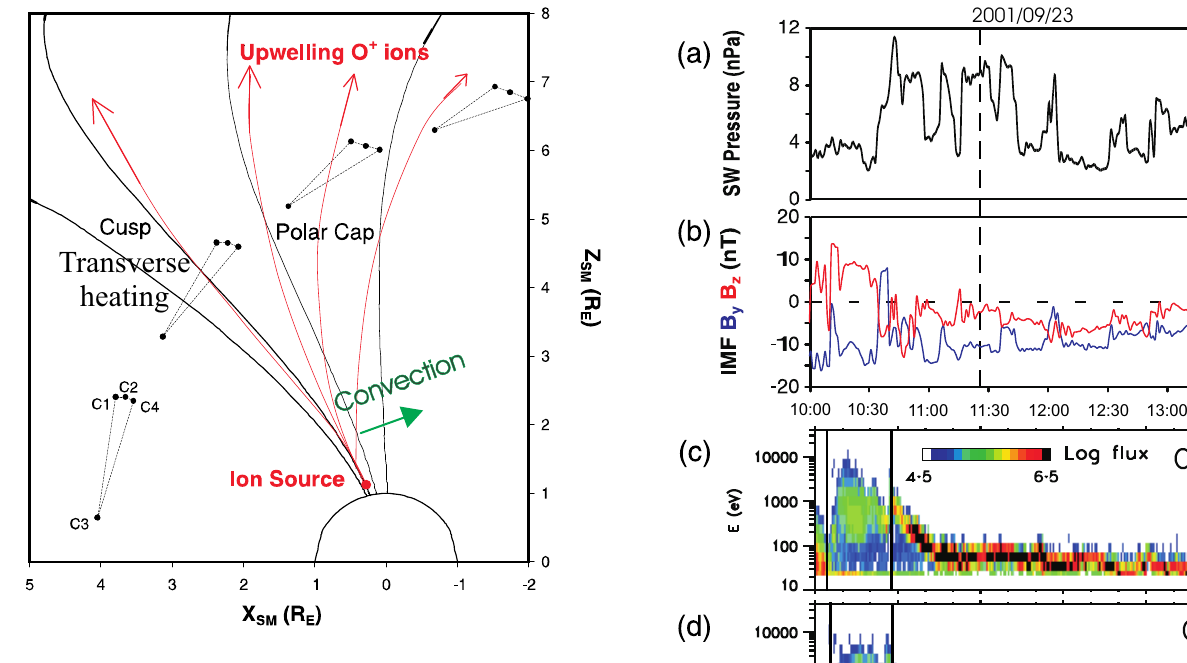
Fig. 1. Drawing of the Cluster orbit configuration in the dayside auroral and polar regions between July and November 2001.